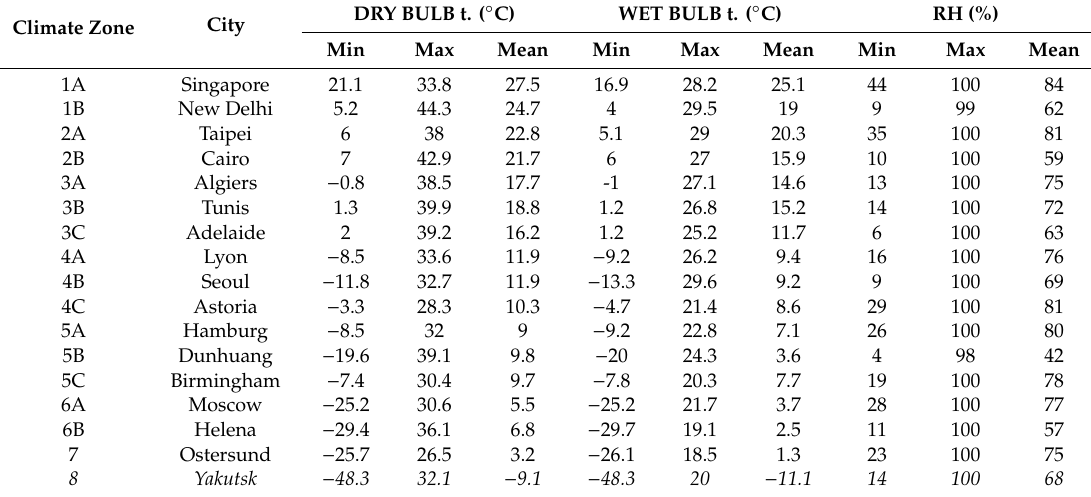
Figure 4. Absorption cooling (ABS) configuration modelled in TRNSYS. Dashed lines are used as control indicators. Table 1. Climate zones defined by ASHRAE and relative representative city. Zone number 8 (in italics) was not considered in this